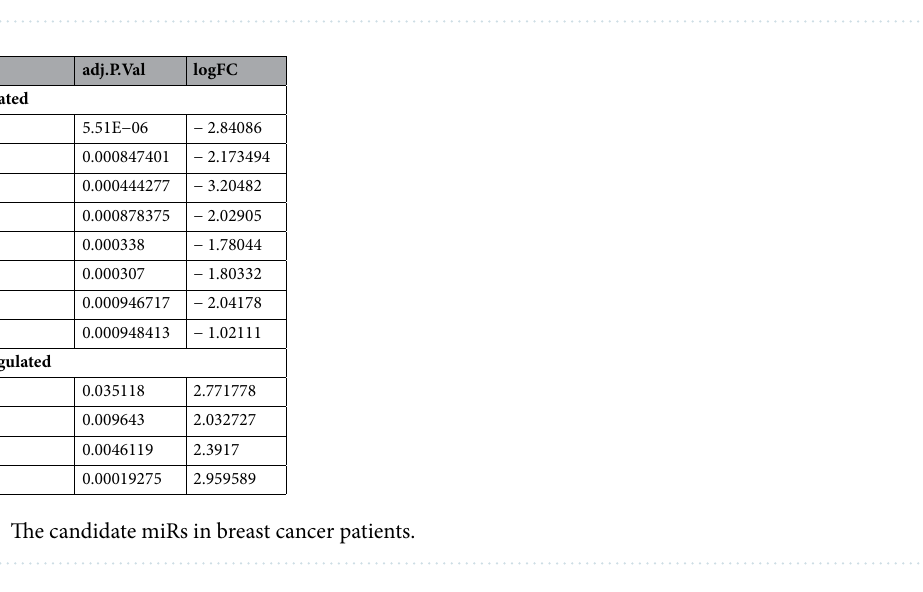
Figure 1. A Venn diagram of the differently expressed lncRNAs, miRs, and mRNAs between GEO and TCGA datasets. Allocation of ( A ) the 157 differently expressed miRs (37 up-regulation and 120 down-regulation), ( B ) 2183 differently expressed mRNAs (996 up-regulation and 1187 down-regulation), and ( C ) 169 differently expressed lncRNAs (102 up-regulation and 67 down-regulation) was found between the datasets in the present study.